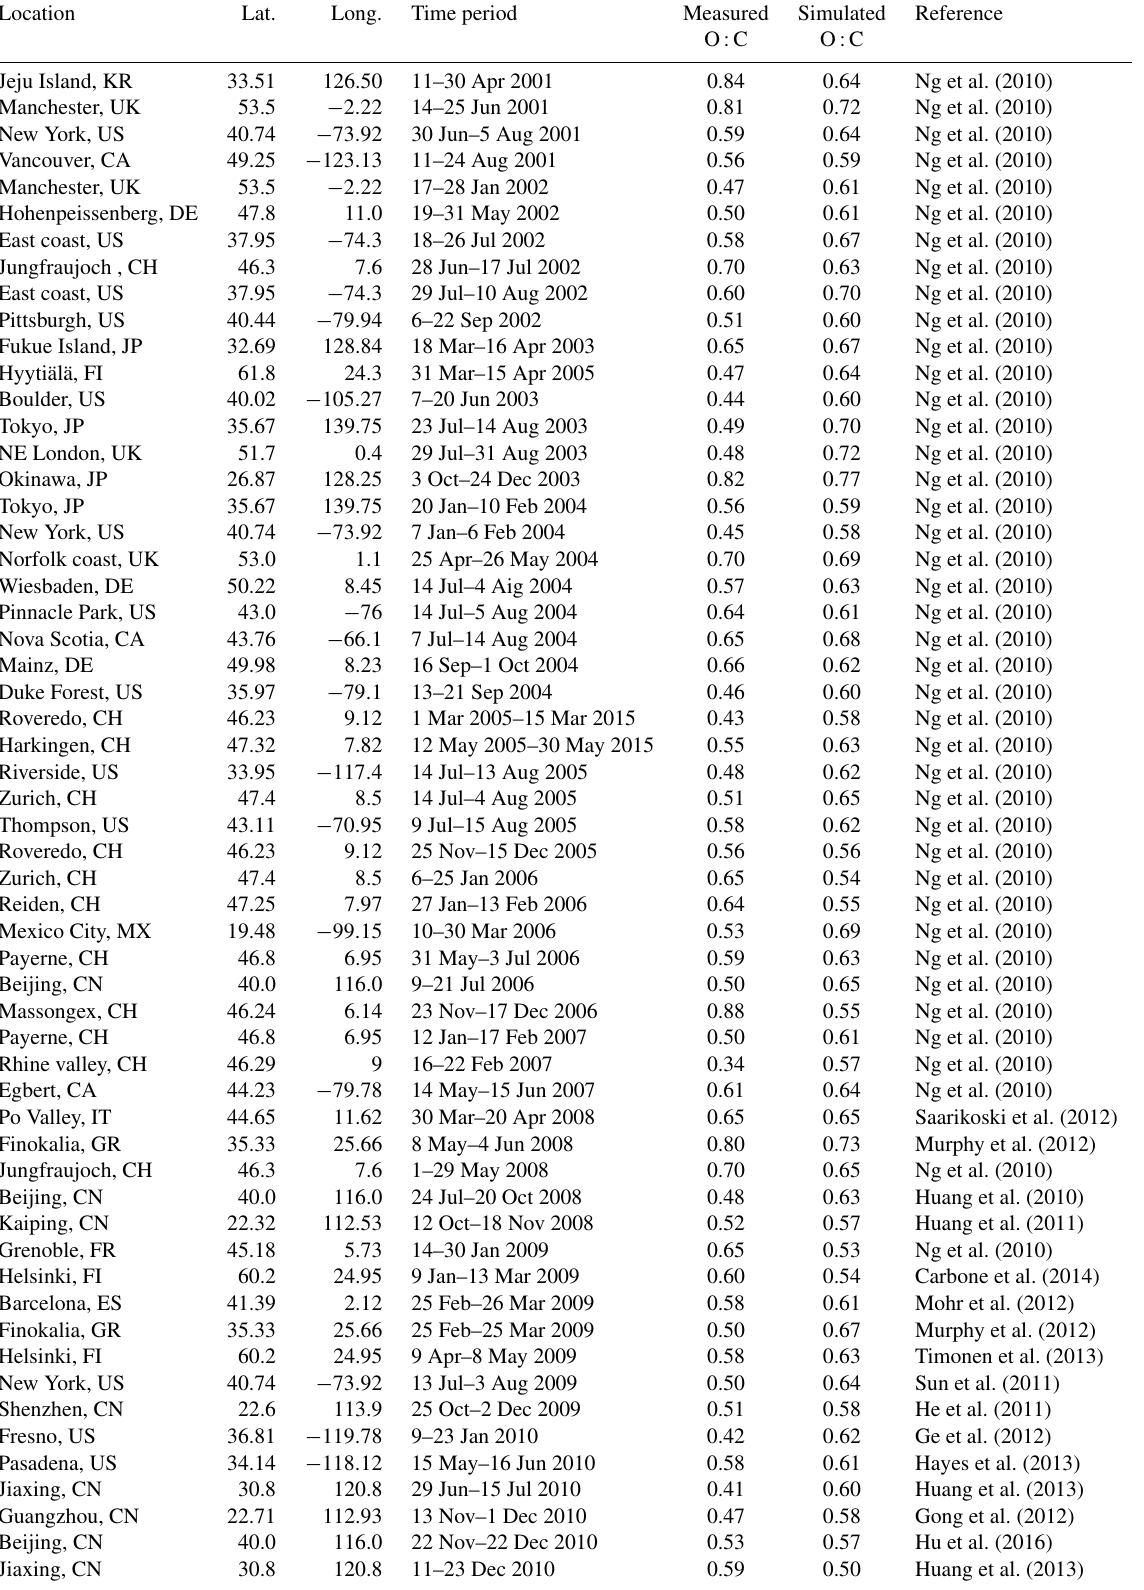
Table 6. Worldwide O:C ratio predictions and observations of OOA. Location Lat. Long. Time period Measured Simulated Reference